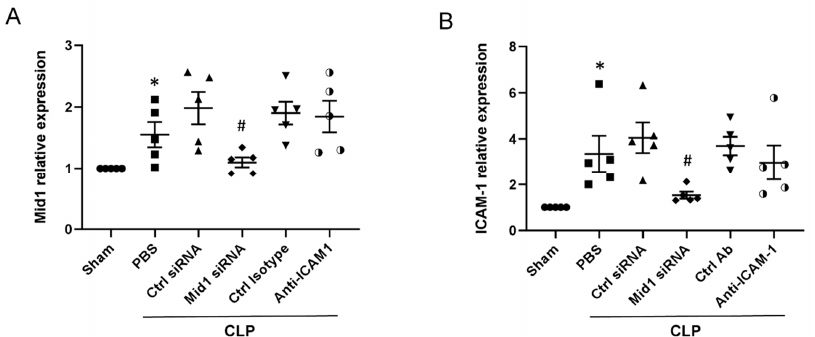
Figure 4. ICAM-1 mRNA expression in lung tissue. Lung tissues were collected, and mRNA was isolated to determine the expression of ( A ) Mid1 and ( B ) ICAM-1. Animals were pretreated with negative control siRNA, Mid1 siRNA, anti-ICAM-1 and an isotype matched control antibody as described in the Materials and Methods section. Control animals were injected with PBS. Data are mean ± SEM and n = 5. * p < 0.05 vs. Sham, # p < 0.05 vs. Control siRNA + CLP.